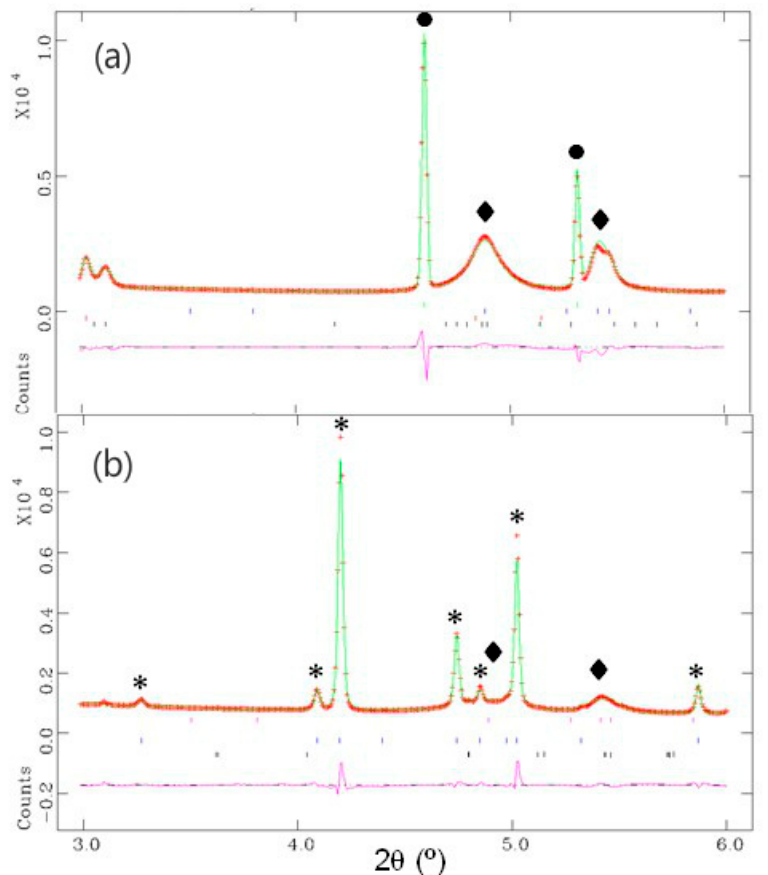
Figure 8. Selected region of the synchrotron X-ray powder diffraction (SXRPD) ( λ = 0.41225 Å) Rietveld plots for ( a ) calcium aluminate paste hydrated with w/s = 0.55 for 30 days at 35 ◦ C, and ( b